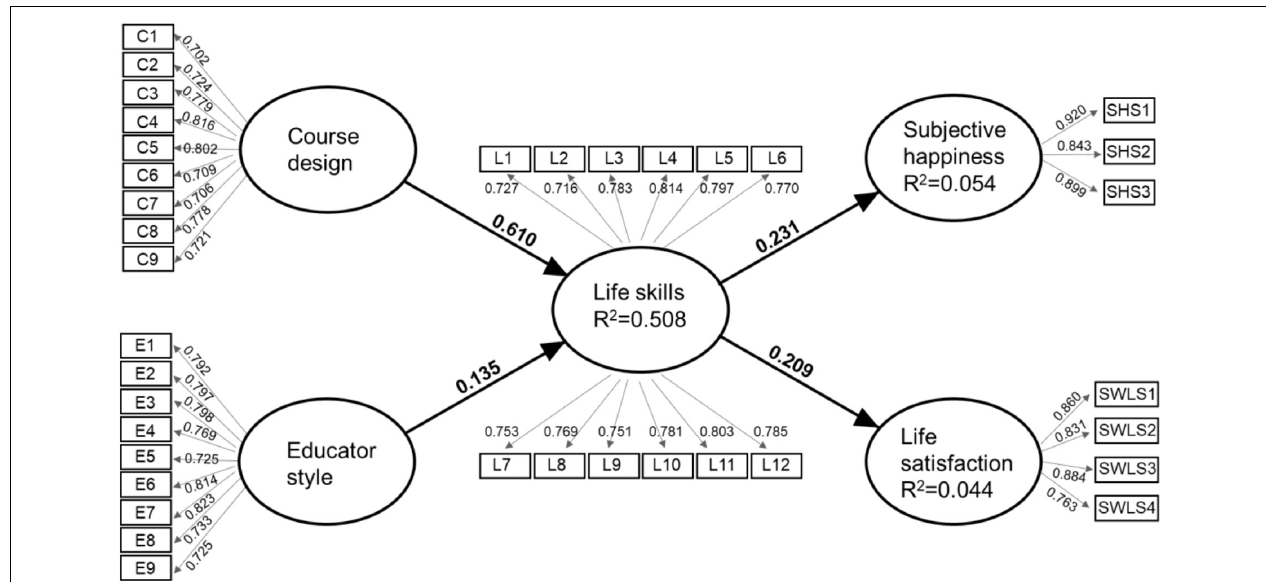
FIGURE 1 | Reflective measurement model and structural model. The latent variables are the predictors (circles), and the corresponding measurement items are the outcomes (rectangles). The model accounts for measurement error at the item level (not shown).